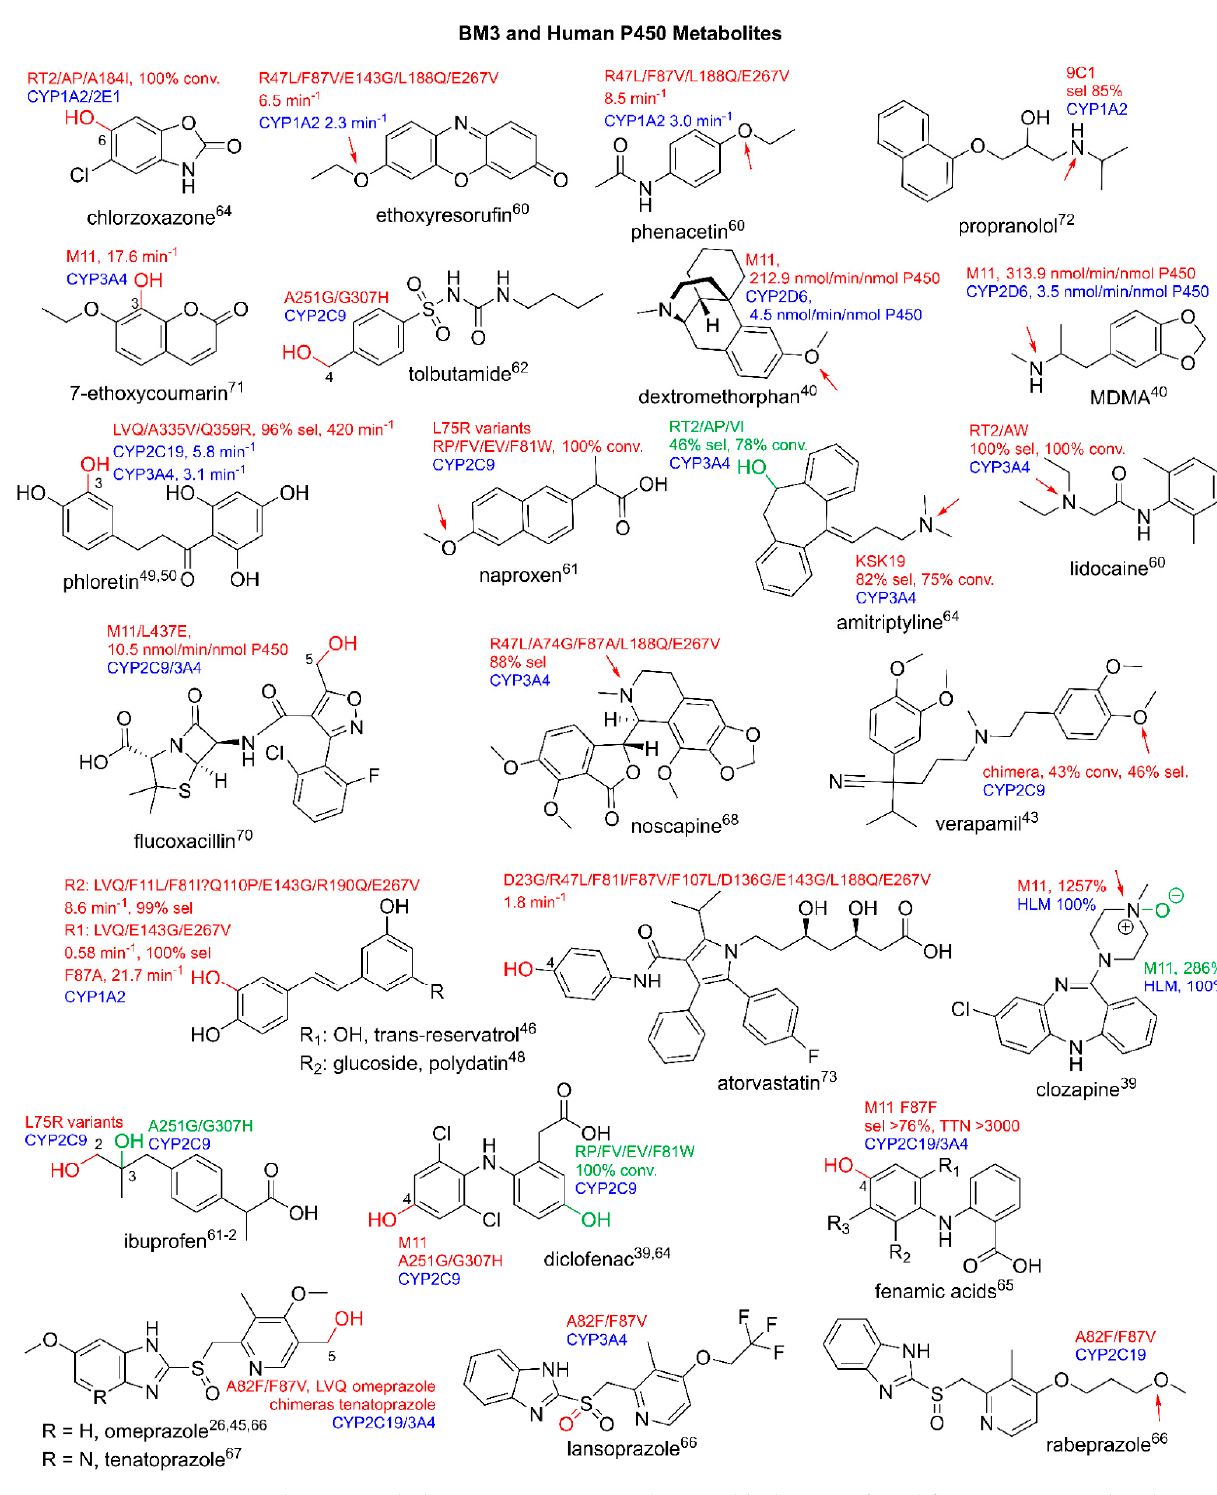
Figure 4. Human P450 and BM3 metabolites. Parent compounds are in black. Sites of modifications are in red and green. Human P450 isoforms are in blue. All arrows indicate the site of N- or O-dealkylation. Conv stands for conversion, Sel stands for selectivity. Rates are in min − 1 , total turnover number (TTN), nmol/min/nmol P450 and relative percentages. Literature references are in